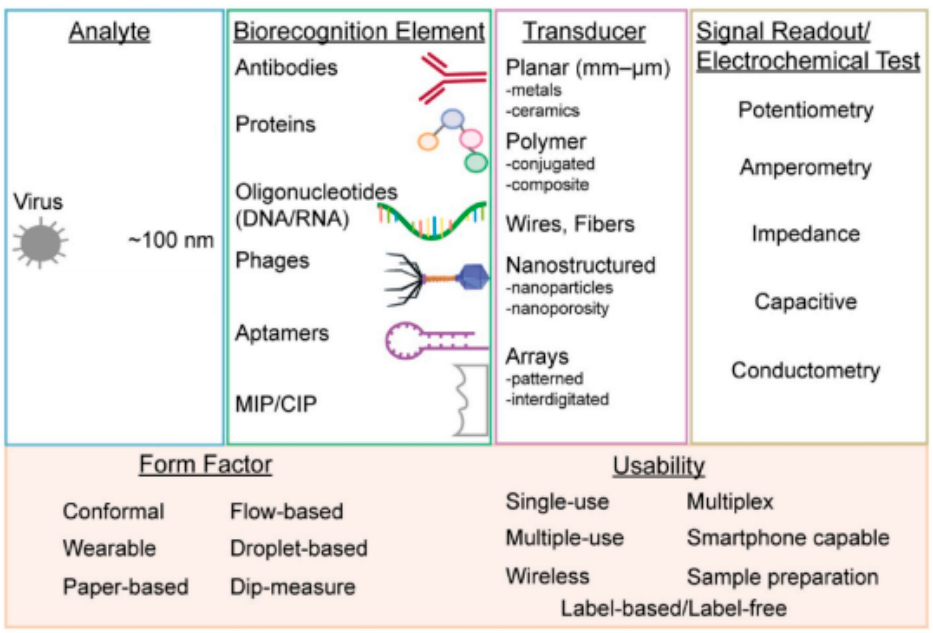
Figure 2. From left to right: virus form factors, types of biorecognition elements, methods to enhance the sensitivity of transducers, various measurement techniques using electrochemical testing and the multi-usability of electrochemical biosensors [26].